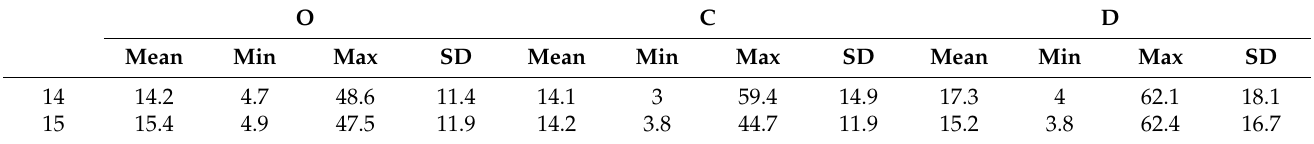
Table 7. Descriptive statistics of relative humidity at each test point on the 14th and 15th (%).